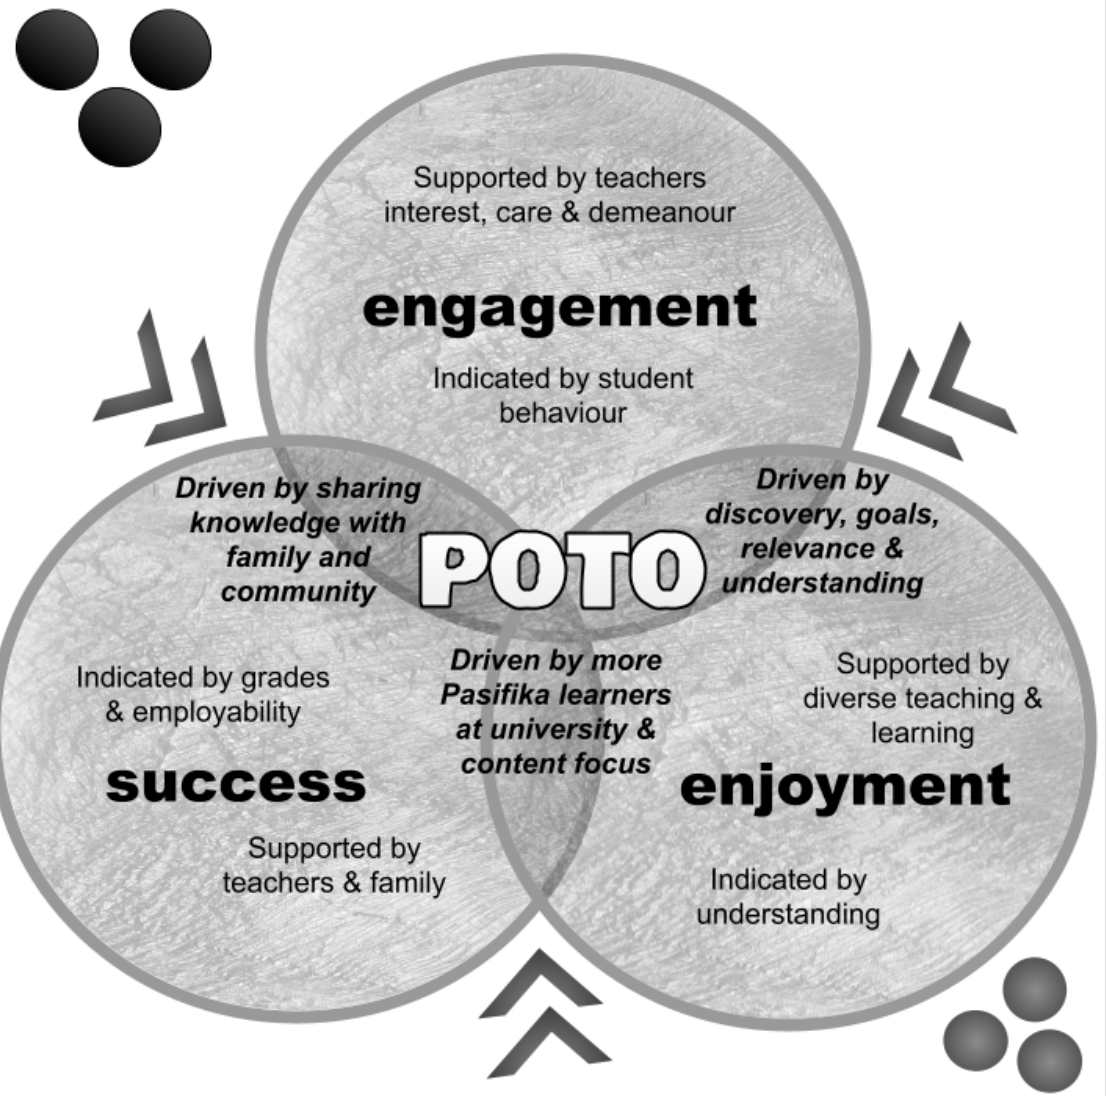
Figure 3. Fata ho poto: Visualising Tongan science learners’ considerations and experiences of engagement, enjoyment and